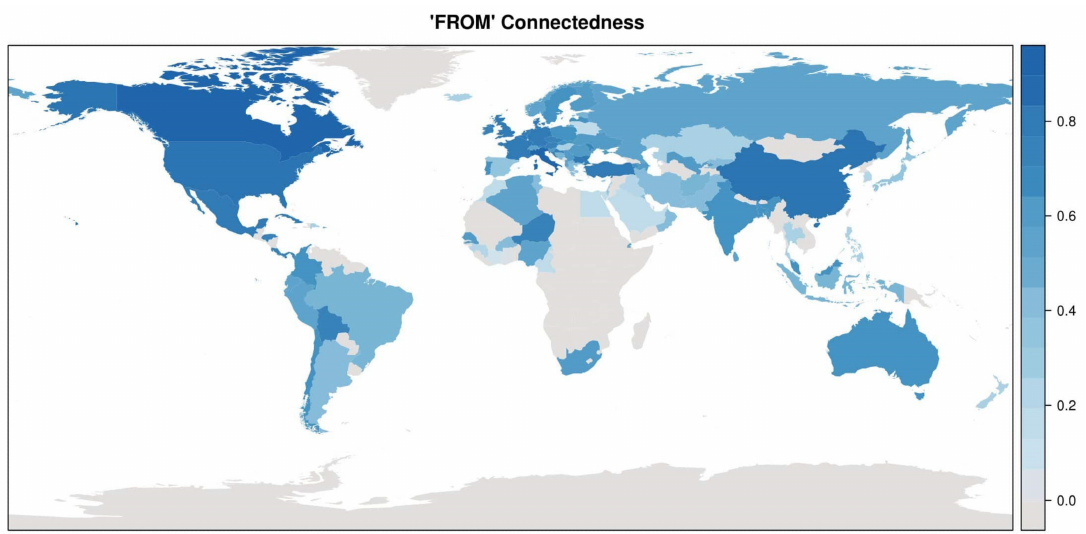
Figure 7. Directional “FROM” connectedness measure, or “FROM”-degrees.